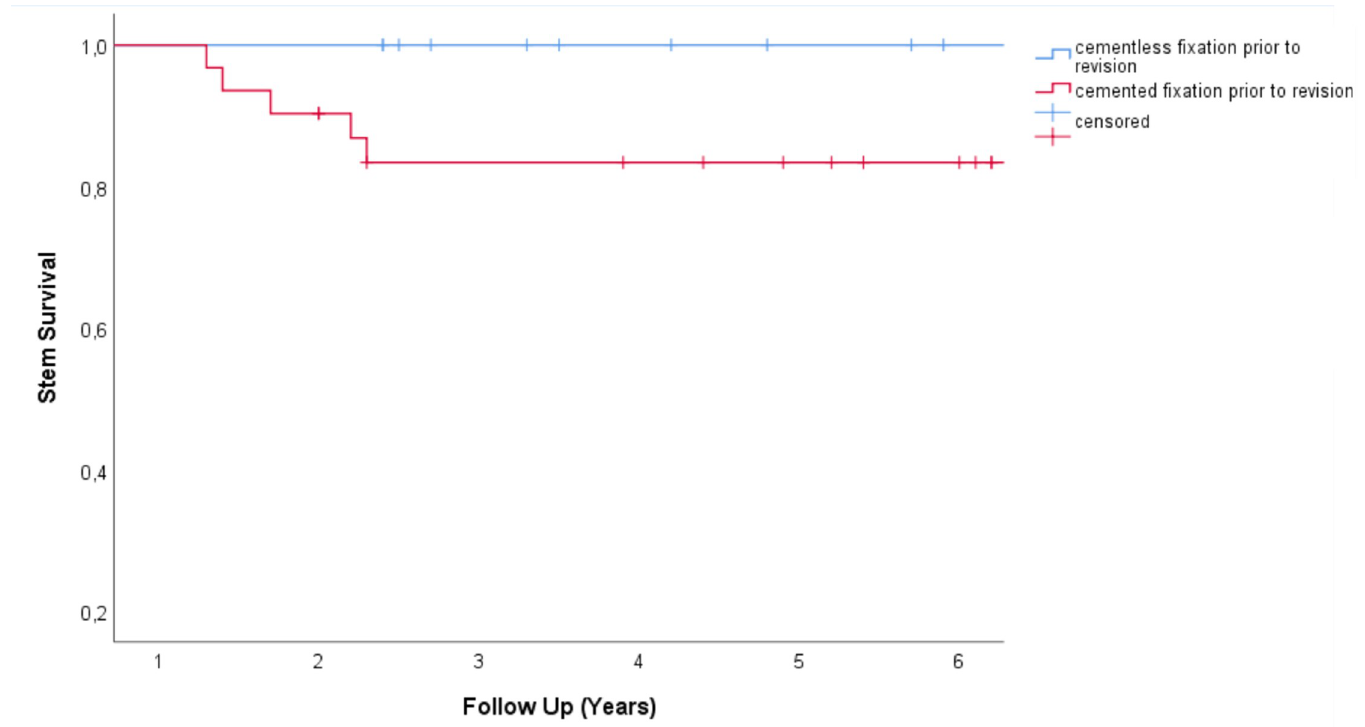
Fig 4. Stem survival compared regarding prior fixation of the revised stem. A cemented fixation of the stem in need for revisions turned out to be a significant risk factor for stem failure after 5 years of follow up of the MUTARS RS stem in our collective (100% (95% CI 100–100%) vs 83.4% (95% CI 70.1–96.7%) p = 0.04 log-rank test).